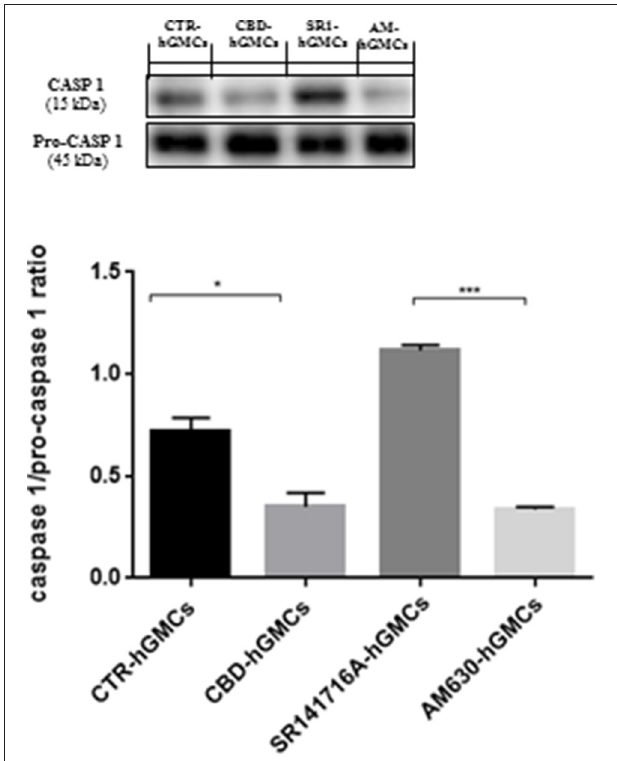
FIGURE 3 | Western blot analysis for CASP1. CASP1 expression is decreased in CBD-hGMSCs compared to CTR-DMSO). The levels of CASP1 are significant increase in SR141716A-hGMSCs compared with CBD-hGMSCs. CTR-hGMSCs vs. CBD-hGMSCs * p <